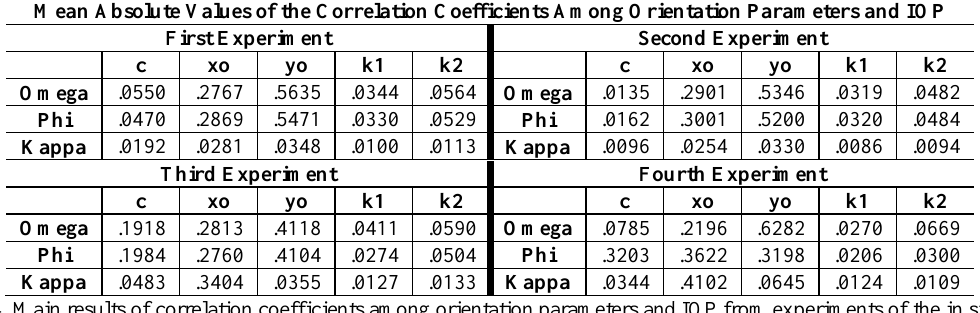
Table 4. Main results of correlation coefficients among orientation parameters and IOP from experiments of the in situ self-